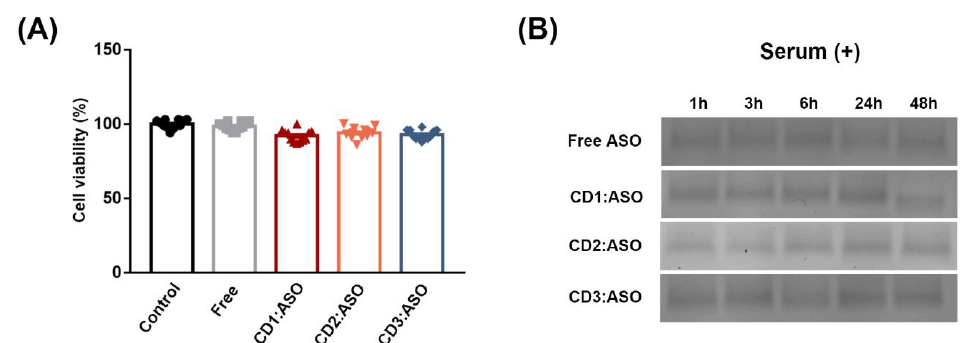
Figure 2. Cytotoxicity and stability of cyclodextrins (CDs):ASO nanocomplexes. ( A ) Effect of the formulations in the viability of ST14A cells (1.5 × 10 6 ) treated during 72 h with CDs loaded with ASO, weight ratio 10:1, 100 nM per well. Living cells were determined using a CellTiter-FLuor assay and expressed as a % of the control. Mean ± S.E.M of 4 technical replicates performed in triplicate. ( B ) Stability profile of ASO in the presence of serum as evaluated by agarose gel electrophoresis. ASO alone or loaded into CDs were incubated with 25% serum for several time points at 37 °C.